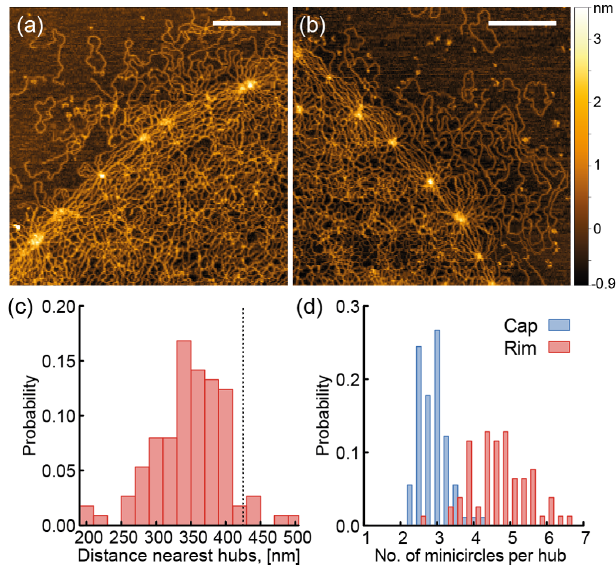
FIG. 3. (a),(b) Enlarged portions of kDNA showing hubs at the periphery. Scale bars are 500 nm. (c) Distribution of distances between nearest hubs. The dashed vertical line represents the diameter of a minicircle if pulled taut, i.e., 1 = 2 × 2500 bp × 0 . 34 nm = bp ¼ 425 nm. (d) Distribution of a number of over- lapping minicircles in the cap and in the